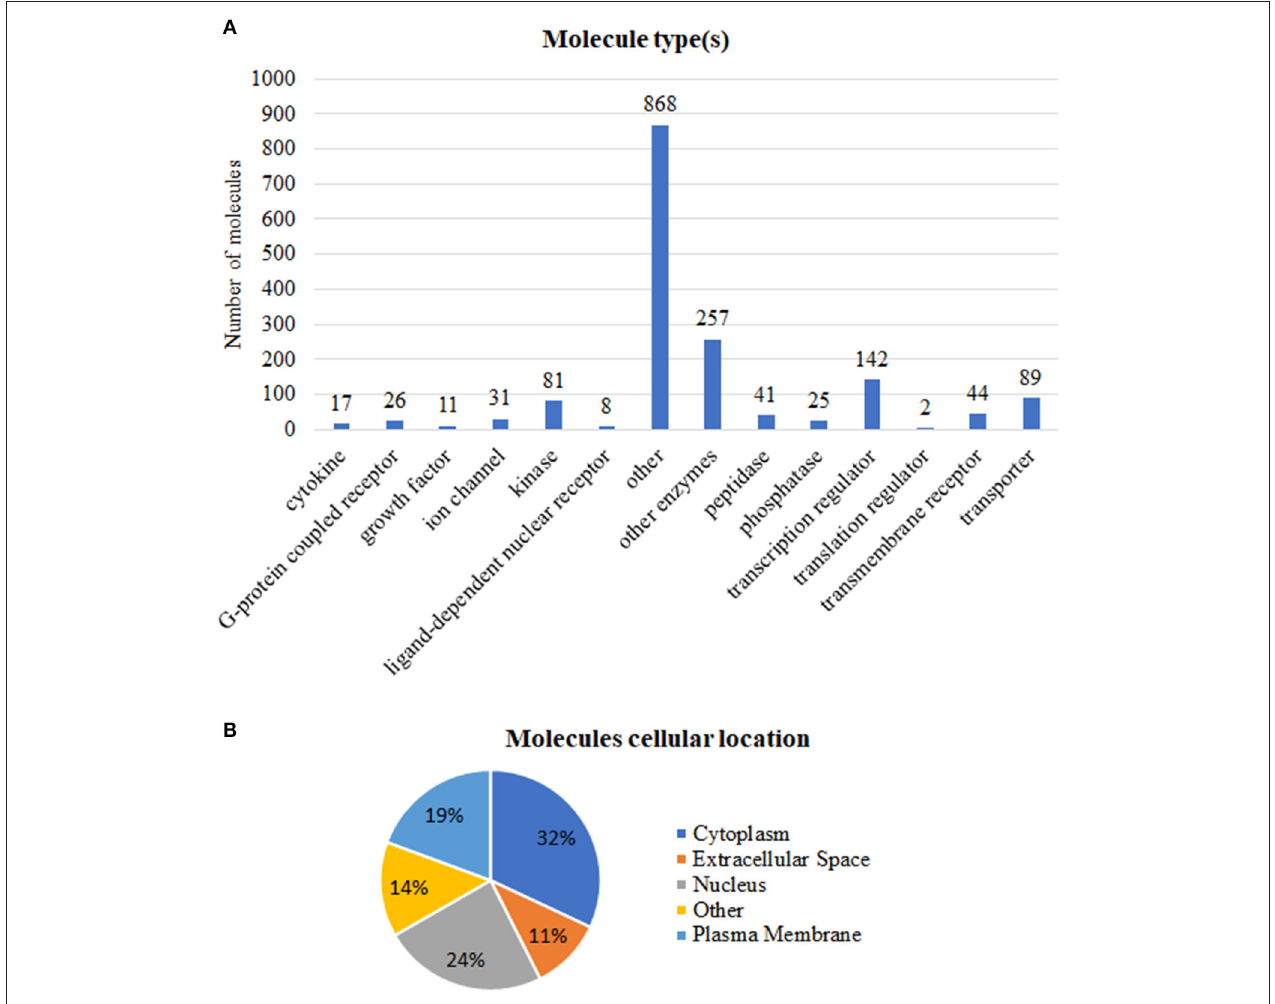
FIGURE 2 | Functional annotations of the 1,642 tumor-associated genes. (A) Number of molecules per type. (B) Percentage of molecules in accordance to subcellular location. Annotations based on the Ingenuity Pathway Analysis manually curated Knowledge Base, QIAGEN software, 2020.